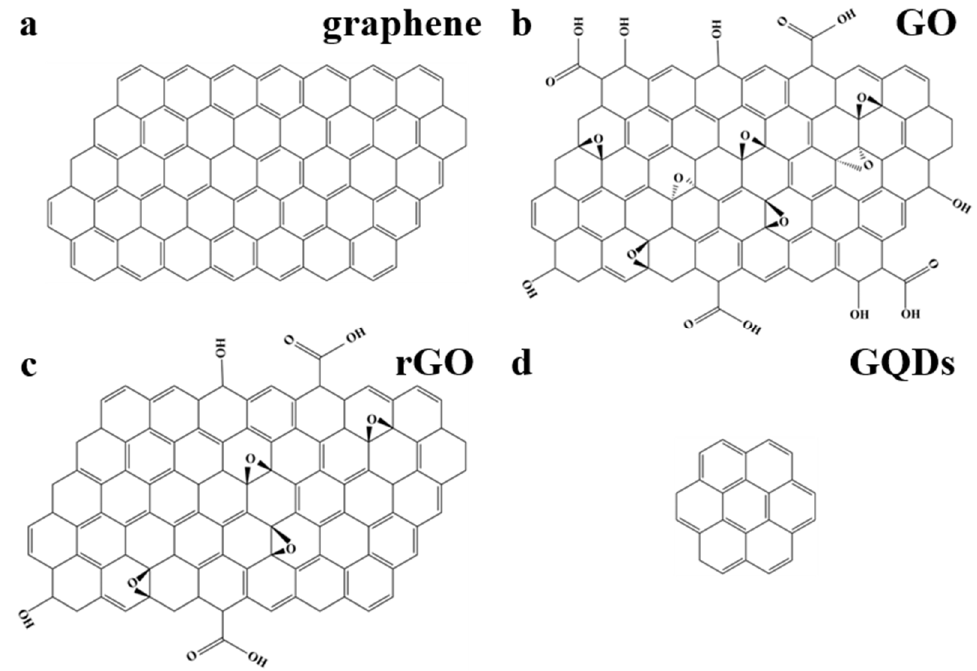
Figure 1. Structural models of single-layer graphene ( a ), graphene oxide ( b ), reduced graphene oxide ( c ), and graphene quantum dots ( d ).